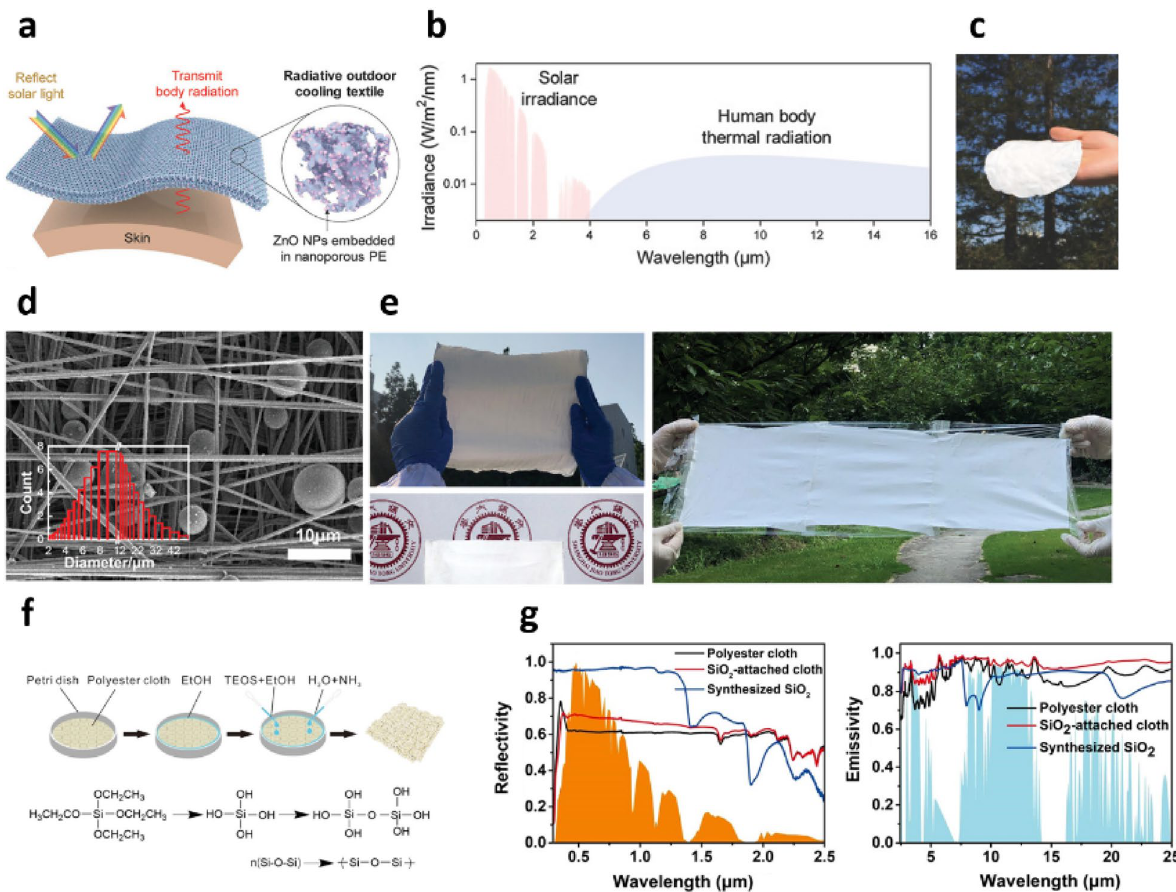
Fig. 4 a Schematic of ZnO NP-embedded nanoporous PE textile. b AM1.5 solar irradiation spectra and thermal radiation of human body simulated using Planck’s law at the skin temperature of 34 ℃ . c Photograph of ZnO-PE fabric. Reproduced with permission from [50]. Copyright 2018, Wiley. d SEM image of hybrid membrane radiator composed of PVDF/TEOS fibers and SiO 2 MPs. e Photograph of scalable flexible hybrid membrane radiator. Reproduced with permission from [59]. Copyright 2020, Wiley. f Fabrication process of SiO 2 -attached fabrics. g Spectral reflectivity and emissivity of SiO 2 -attached fabrics and raw materials. Reproduced with permission from [60]. Copyright 2021, American Chemical